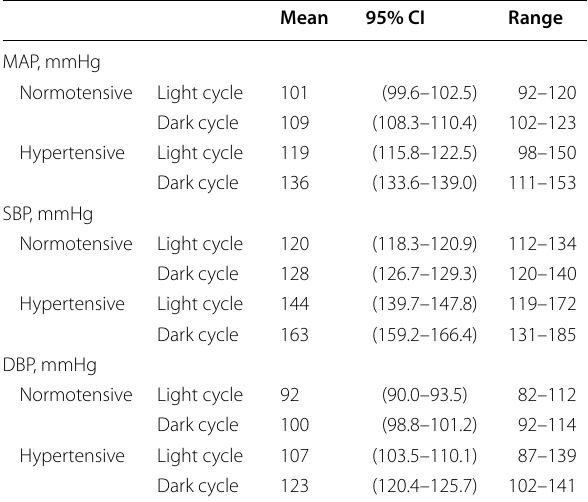
Table 1 Blood pressure in Angiotensin II‑induced hypertension